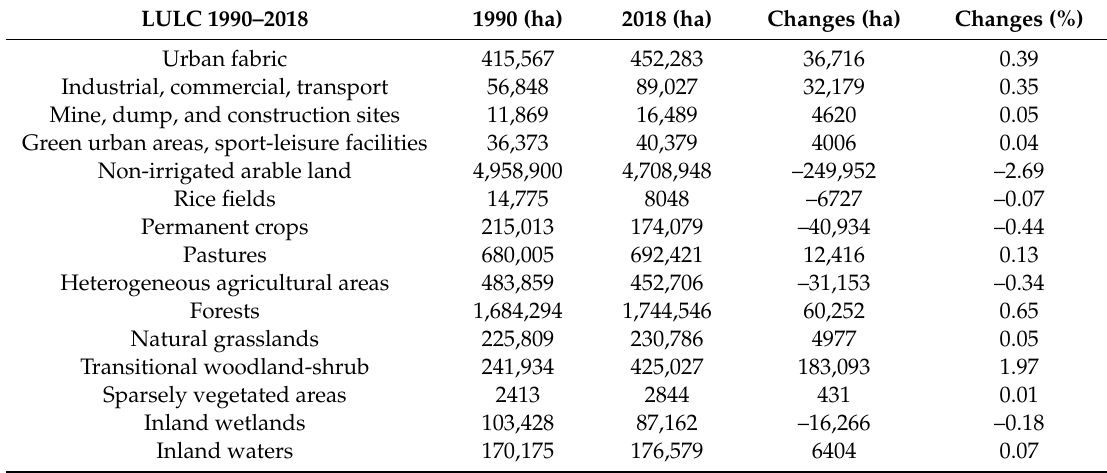
Figure 5. LULC change over time by percent change. Table 3. Area a ff ected by LULC change in Hungary between 1990 and